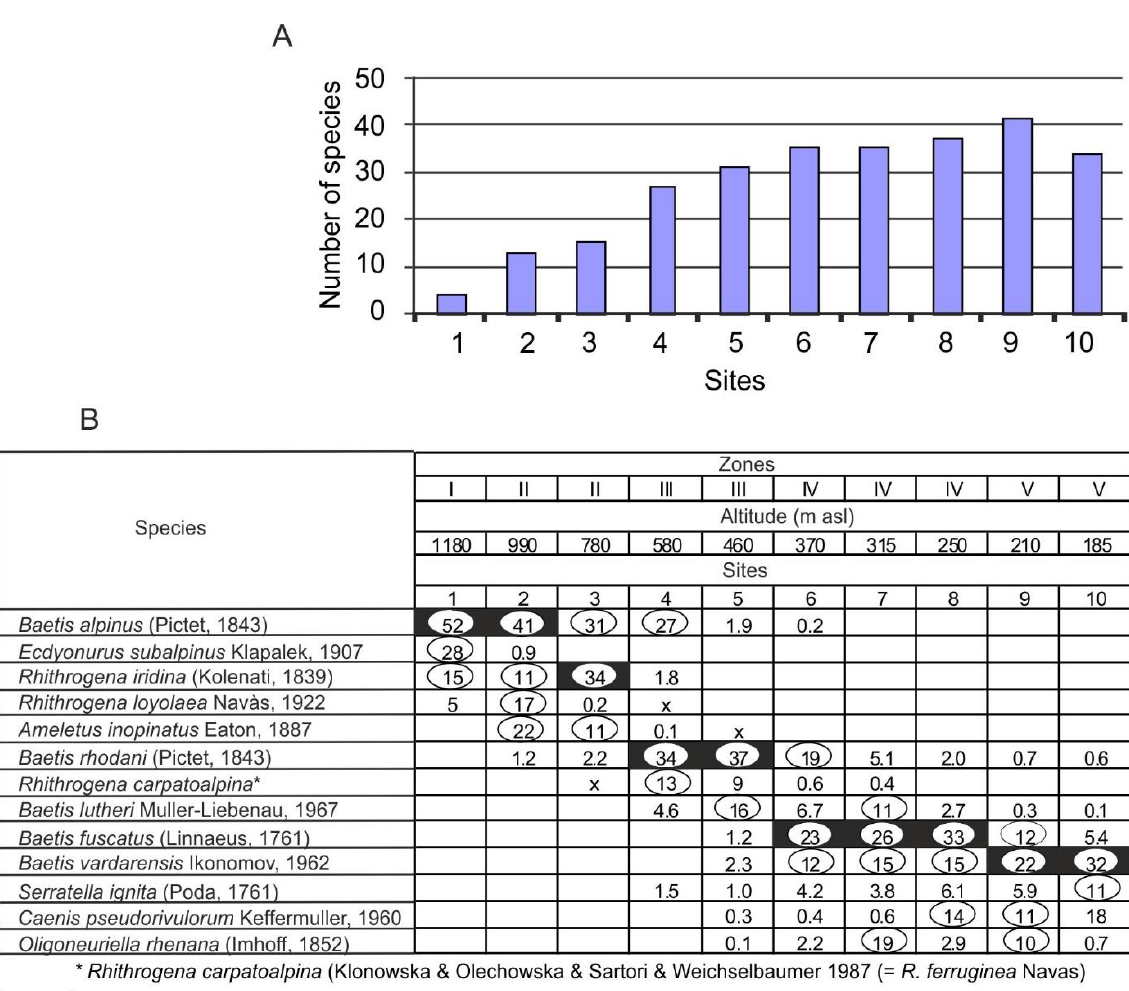
Figure 2. The number of species ( A ) and percentage of dominant species ( B ) of Ephemeroptera in the Raba River in 1969–1970 (according to [15],